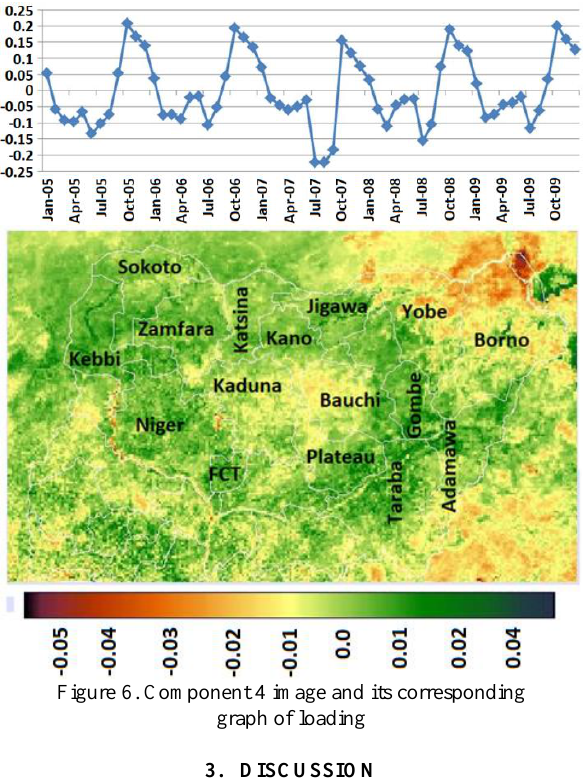
Figure 6. Component 4 image and its corresponding graph of